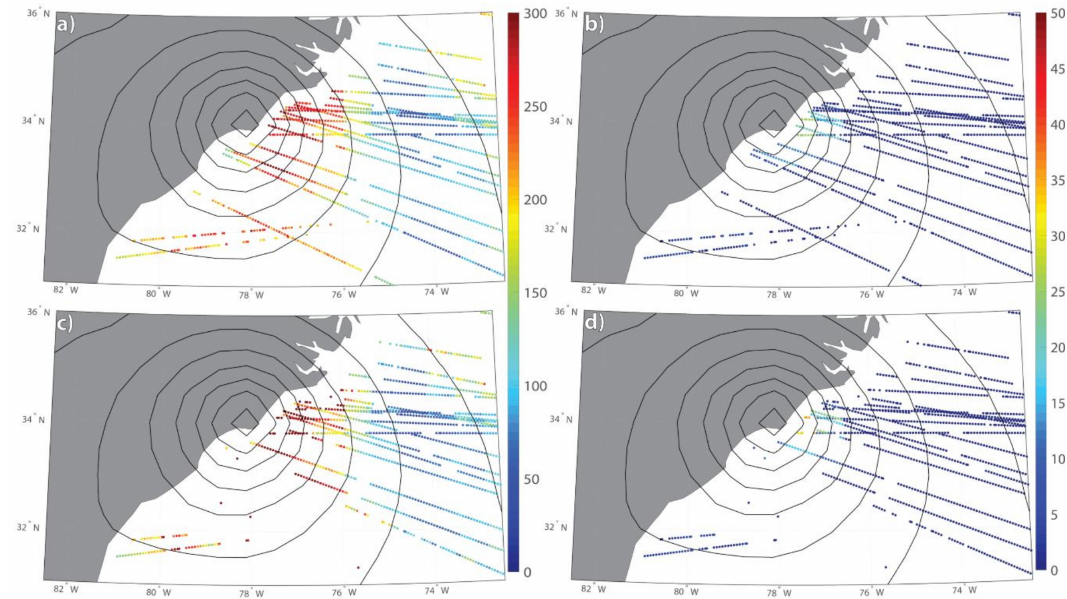
Figure 3. CYGNSS Surface Heat Flux Observations of Hurricane Florence on 14 September 2018. Contours of sea level pressure [black lines] at 1800 UTC with CYGNSS observations spanning ± 3 hours around this time. ( a ) LHF with FDS winds, ( b ) SHF with FDS winds; ( c ) LHF with YSLF winds; ( d ) SHF with YSLF